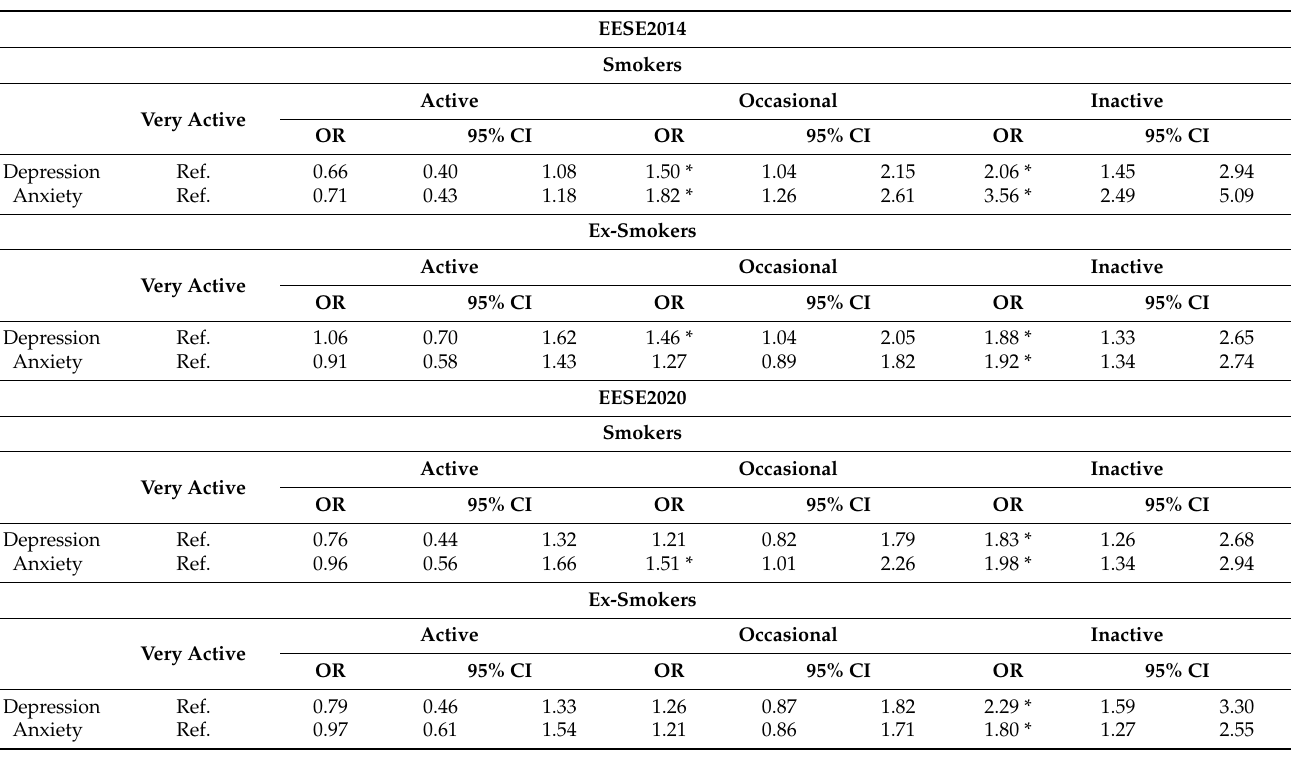
Table A3. Odd ratio for depression and anxiety, according to participants’ frequency of physical activity: EESE2014 and EESE2020.